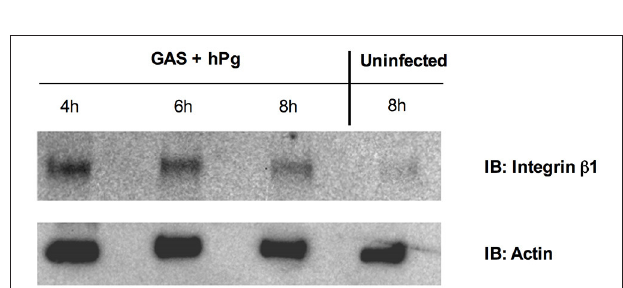
FIGURE 6 | Activation of hPg by AP53R + S − causes cytoplasmic localization and subsequent degradation of integrin β 1 in a keratinocyte wound. Scratch wounds were produced as in Figure 1 . HaCaT wounds were infected with AP53R + S − at MOI 5 with 7 µ g/mL of hPg. Over the course of 8h, lysates representing cytoplasmic fractions at different timepoints were collected and assessed for the presence of integrin β 1 via Western blotting with an antibody against Integrin β 1. An uninfected wound was also assessed for integrin β 1 levels in the cytoplasm, indicating Integrin β 1 levels lower in uninfected cytoplasmic